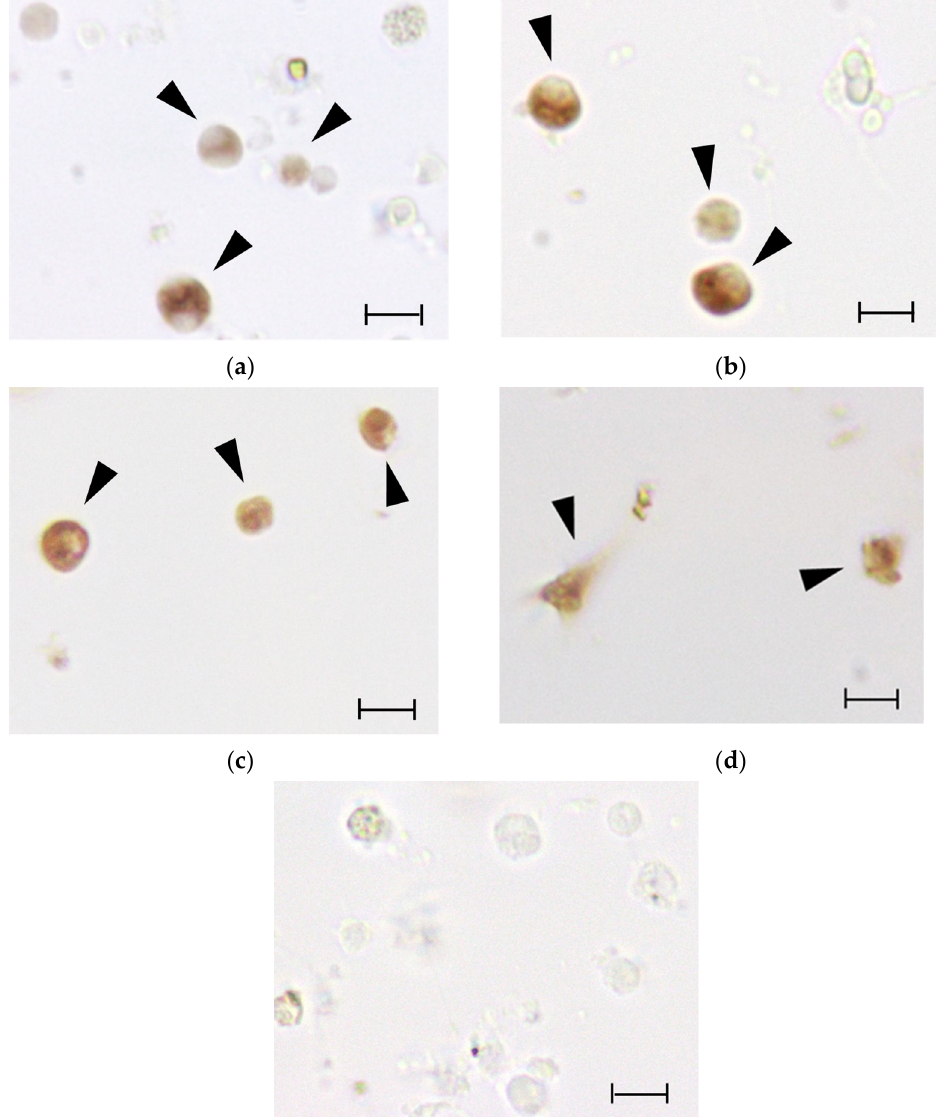
Figure 5. ISH with anti-sense riboprobes for ( a ) cr-Prdx2 , ( b ) cr-Prdx3 and ( c , d ) cr-Prdx4 , and sense riboprobe, for ( e ) cr-Prdx4 as reference, on hemocyte monolayers from three-day Cd treatment. Brown color: riboprobe staining. Arrowheads: labeled hemocytes. Scale bar: 10 μ m.